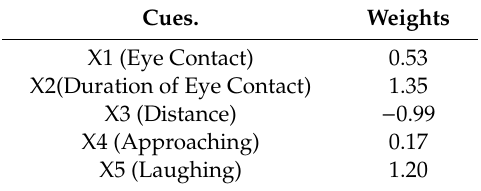
Table 1. Optimized parameters of weights obtained from the training. Cues.